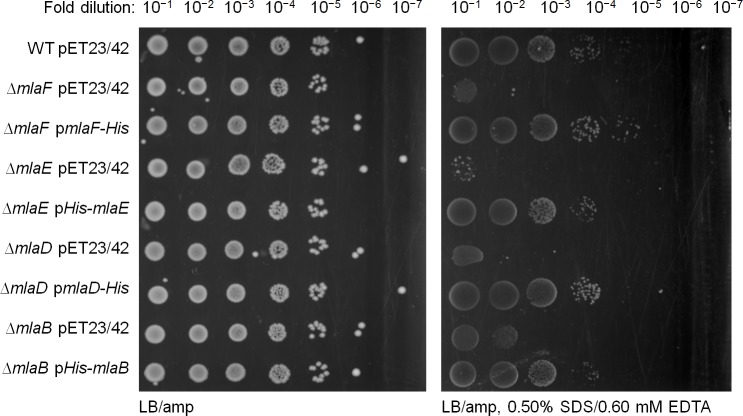
His-tagged Mla proteins are able to rescue SDS/EDTA sensitivity in the respective mla mutant strains.Serial dilutions of cultures of wild-type (WT), ∆mlaF, ∆mlaE, ∆mlaD and ∆mlaB strains harboring pET23/42 empty vector, pET23/42mlaF-His (pmlaF-His), pET23/42His-mlaE (pHis-mlaE), pET23/42mlaD-His (pmlaD-His) or pET23/42His-mlaB (pHis-mlaB), respectively, were spotted on LB agar plates containing 200 μg/mL ampicillin, supplemented with or without 0.50% SDS and 0.60 mM EDTA as indicated, and incubated overnight at 37°C.